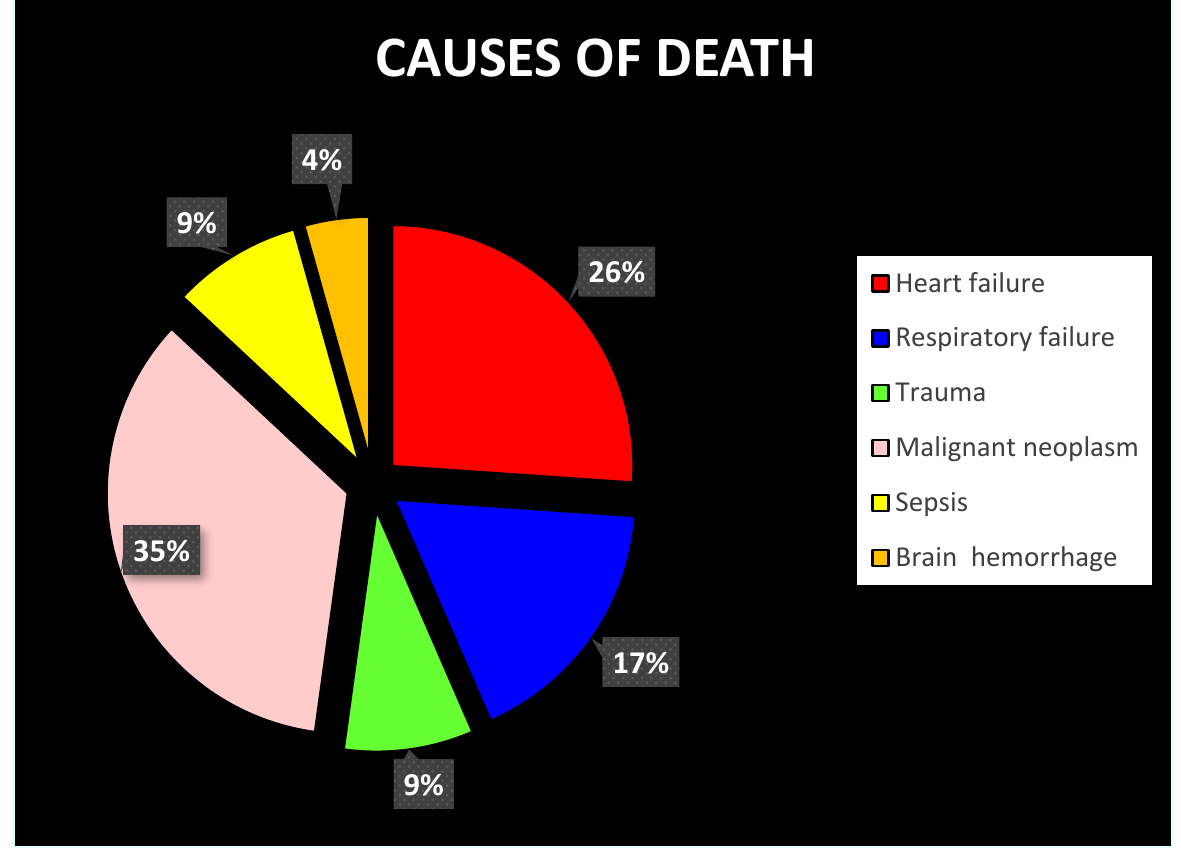
Figure 1. Causes of death among the sample. After death, bodies were transferred to a room with a known humidity and tempera- ture and monitored over time. The range of temperatures was 20–23 ◦ C (22.12 ± 0.64 ◦